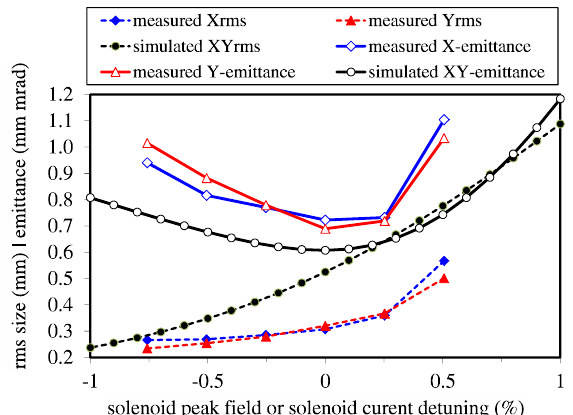
FIG. 20. Measured and simulated rms size and emittance at EMSY1 for 1 nC versus main solenoid current